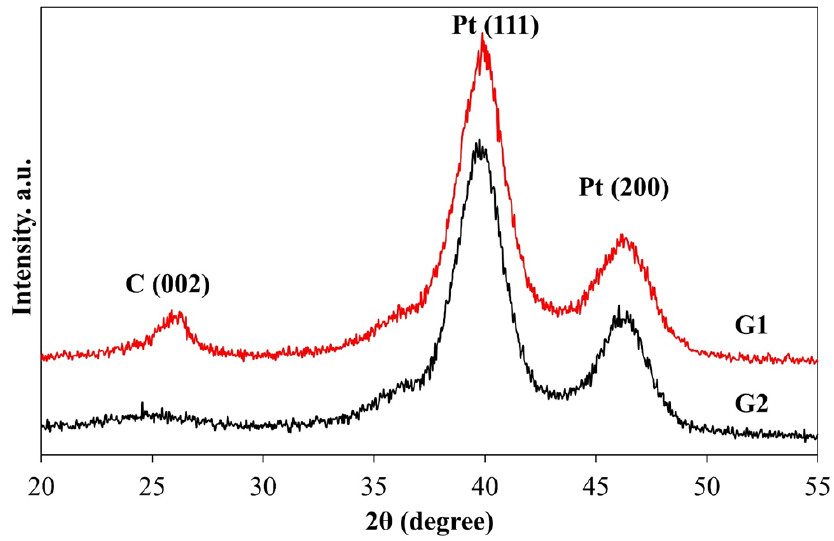
Figure 3. XRD patterns of Pt/C materials.